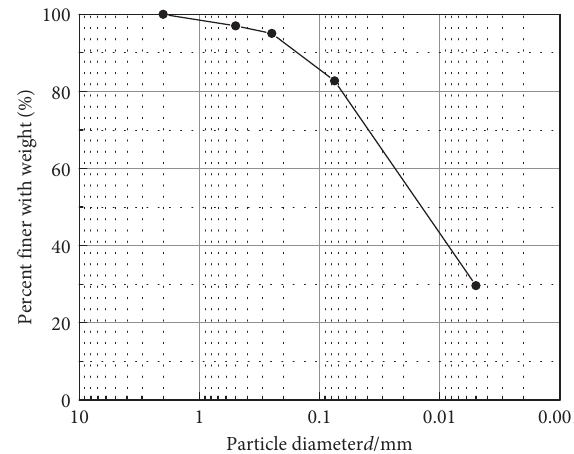
Figure 4: Grain size distribution of clay used in the